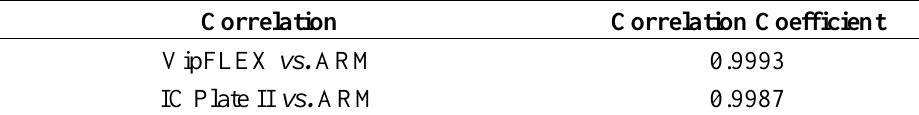
Table 3. Pearson correlation model for the second strategy.